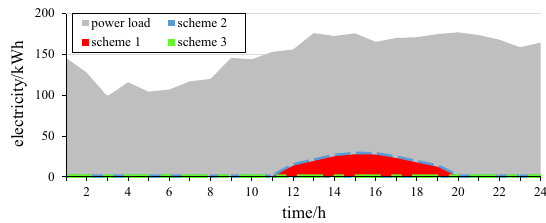
Fig. 21 Electricity energy outputs of CHP unit in winter